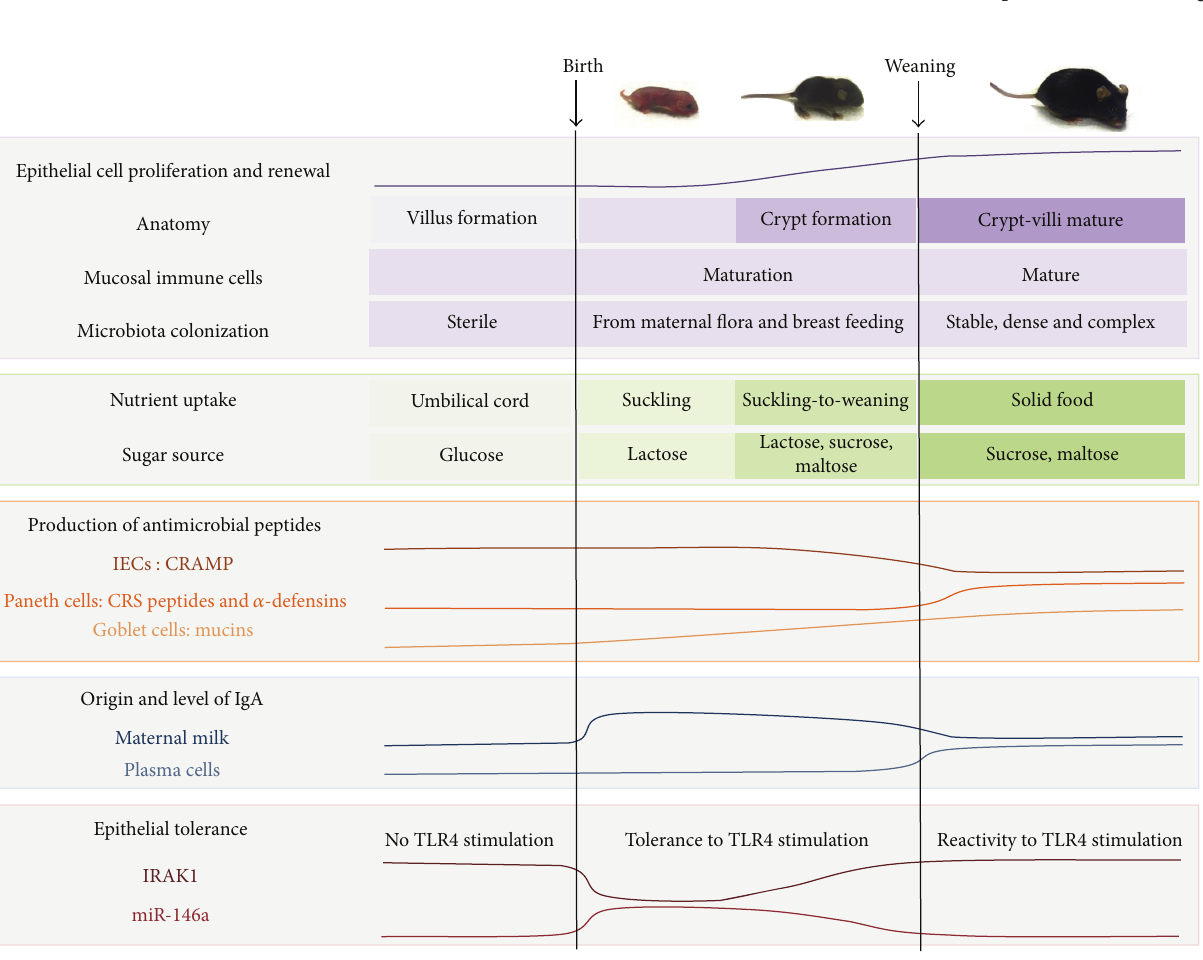
Figure 3: Summary of changes taking place in the intestine during the fetal period, neonatal period, and adult period. Please refer to the text for details. IECs: intestinal epithelial cells: CRAMP: cathelin-related antimicrobial peptide; CRS: cryptdin-related sequence; IgA: immunoglobulin A; TLR: toll-like receptor; IRAK1: interleukin-1 receptor-associated kinase 1; miR-146a: microRNA